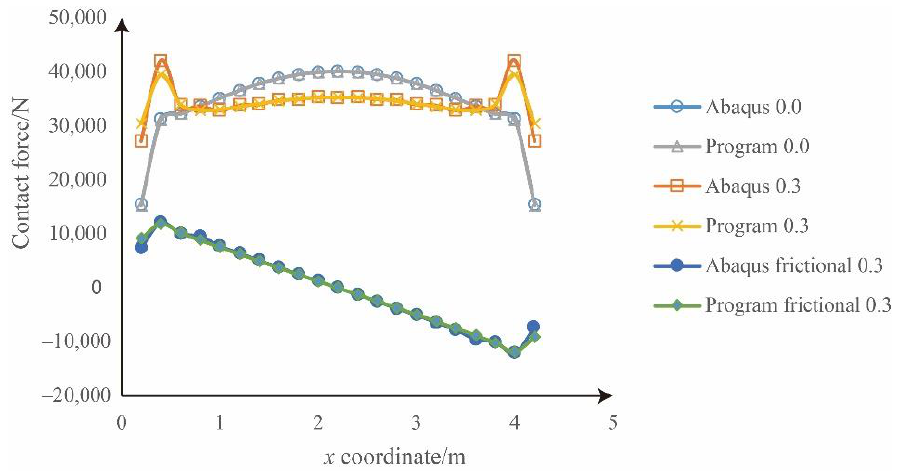
Figure 4. Validation of the contact results computed by the program.